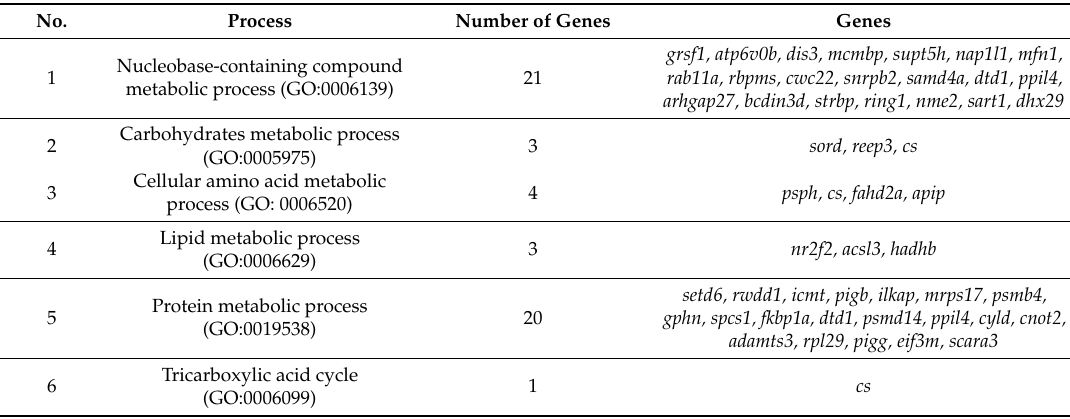
Figure 8. Number of DEG assigned to biological processes. Table 6. Primary metabolism processes and